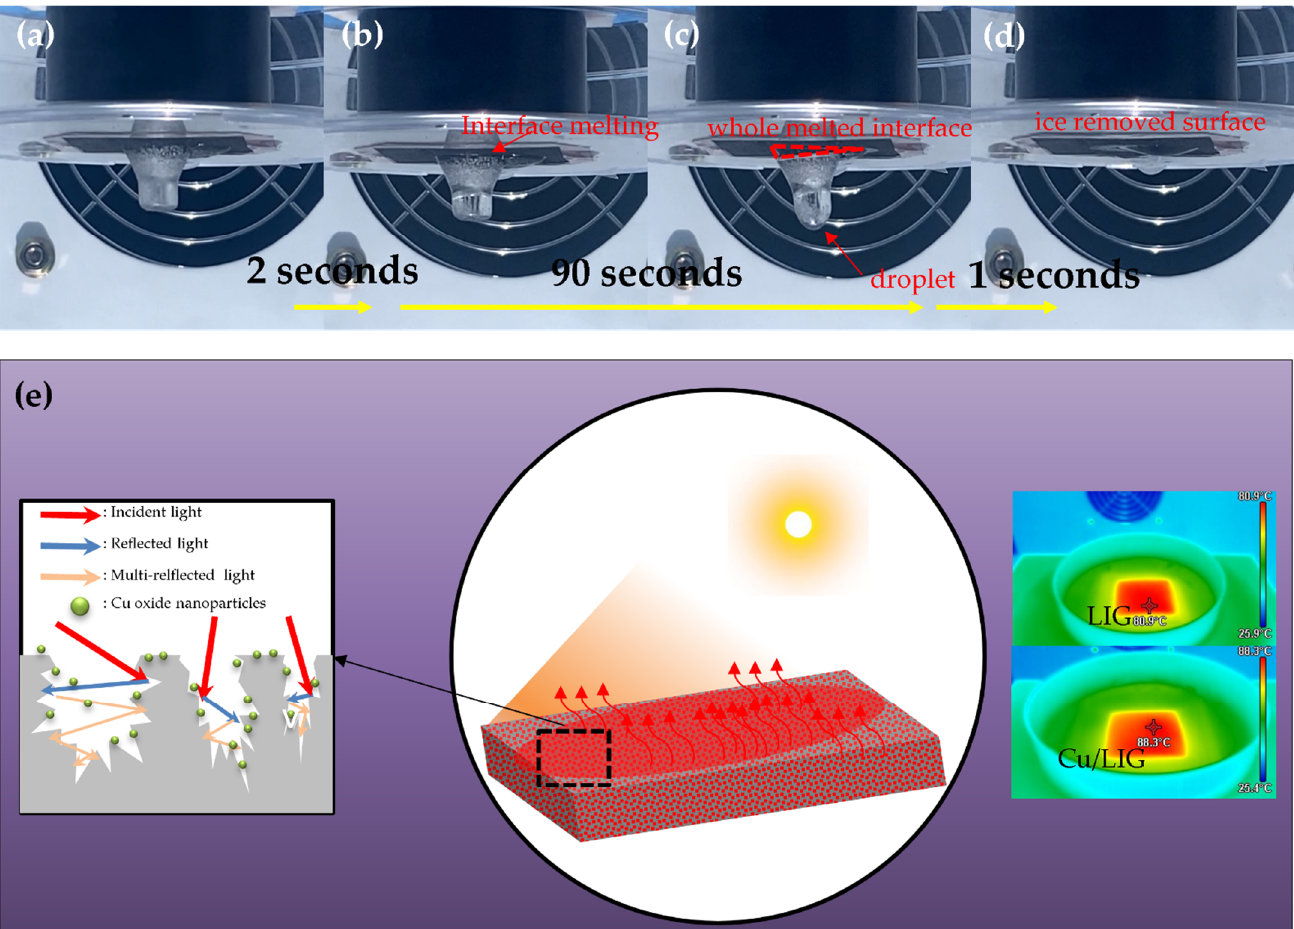
Figure 5. ( a – d ) Actual images of deicing based on photothermal effect with Cu/LIG fabricated with 5 μL of Cu solution. ( e ) Schematic illustration of the deicing mechanism based on photothermal effect and thermal image of the saturated temperature of LIG and Cu/LIG with 1 Sun.